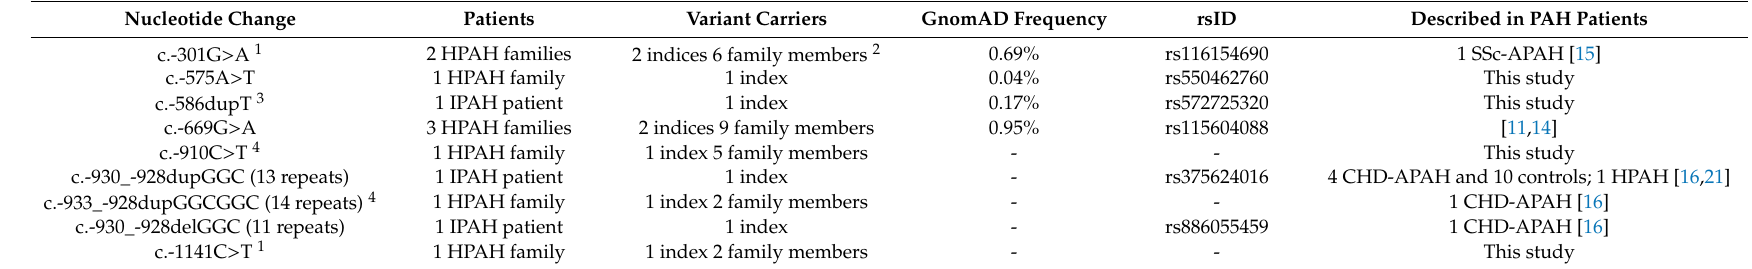
Table 2. Variants identified in the 5 (cid:48) UTR of the BMPR2 in I / HPAH